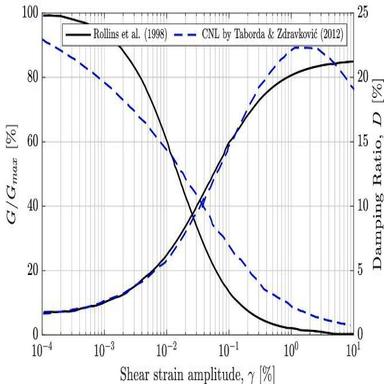
CNL model compared with empirical curves proposed by Rollins et al.. Modified from Taborda & Zdravkovi´c.